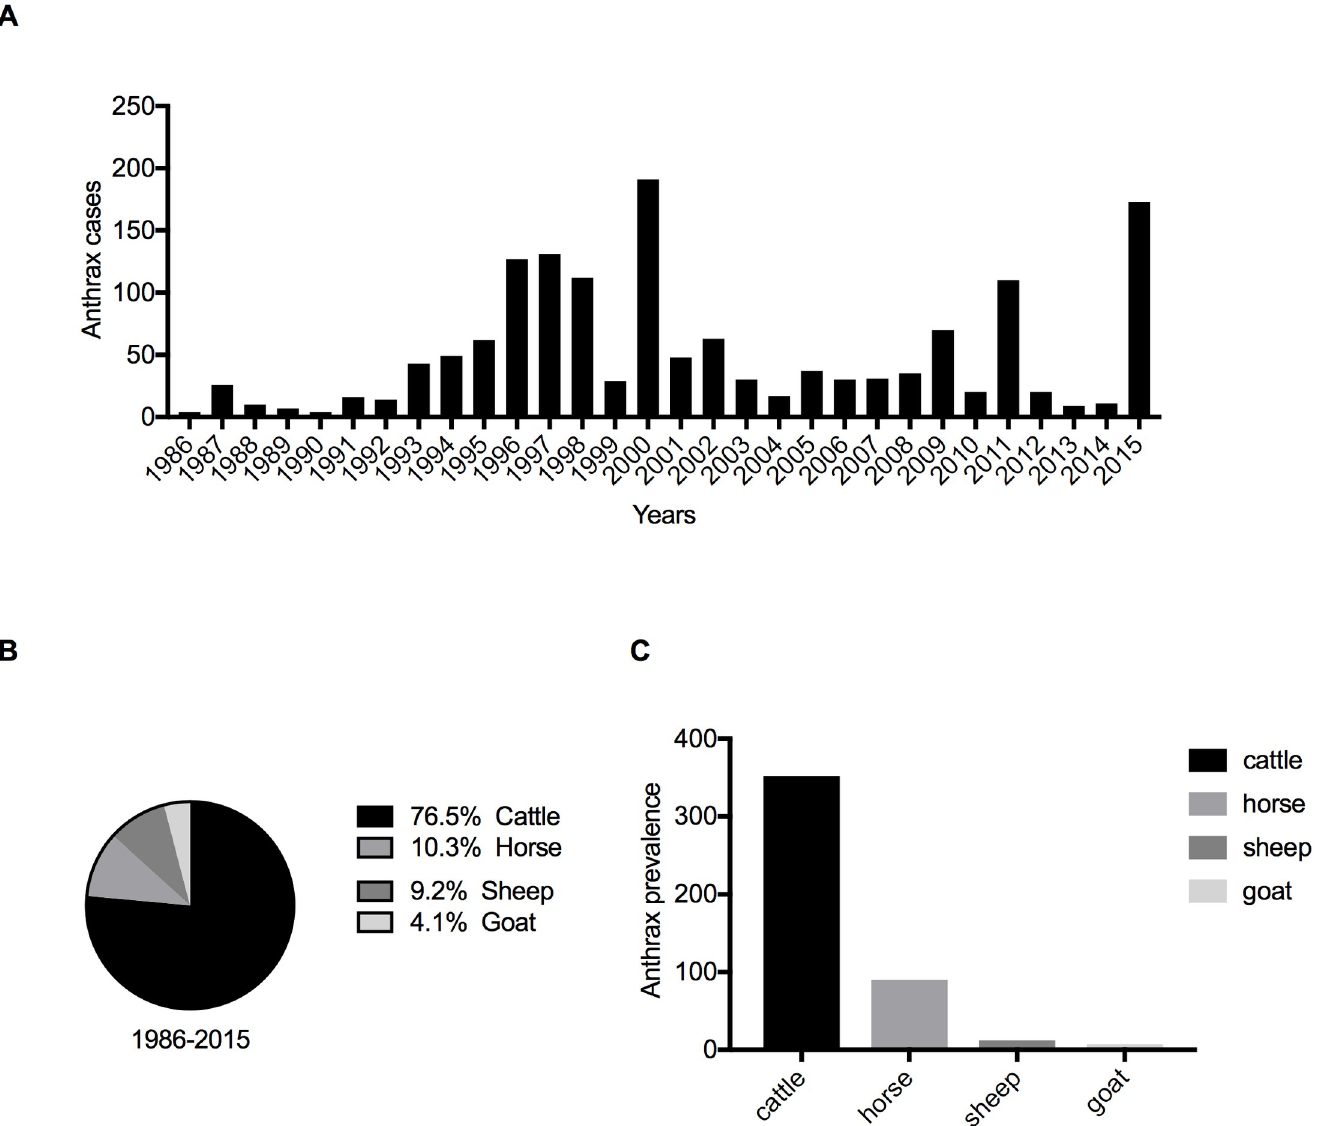
Fig 1. The distribution of anthrax in Khuvsgul Province between 1986 and 2015. (A) Annual dynamics of registered livestock anthrax cases. (B) Reported anthrax cases in livestock species. (C) Prevalence of anthrax in livestock by species for 30 years.